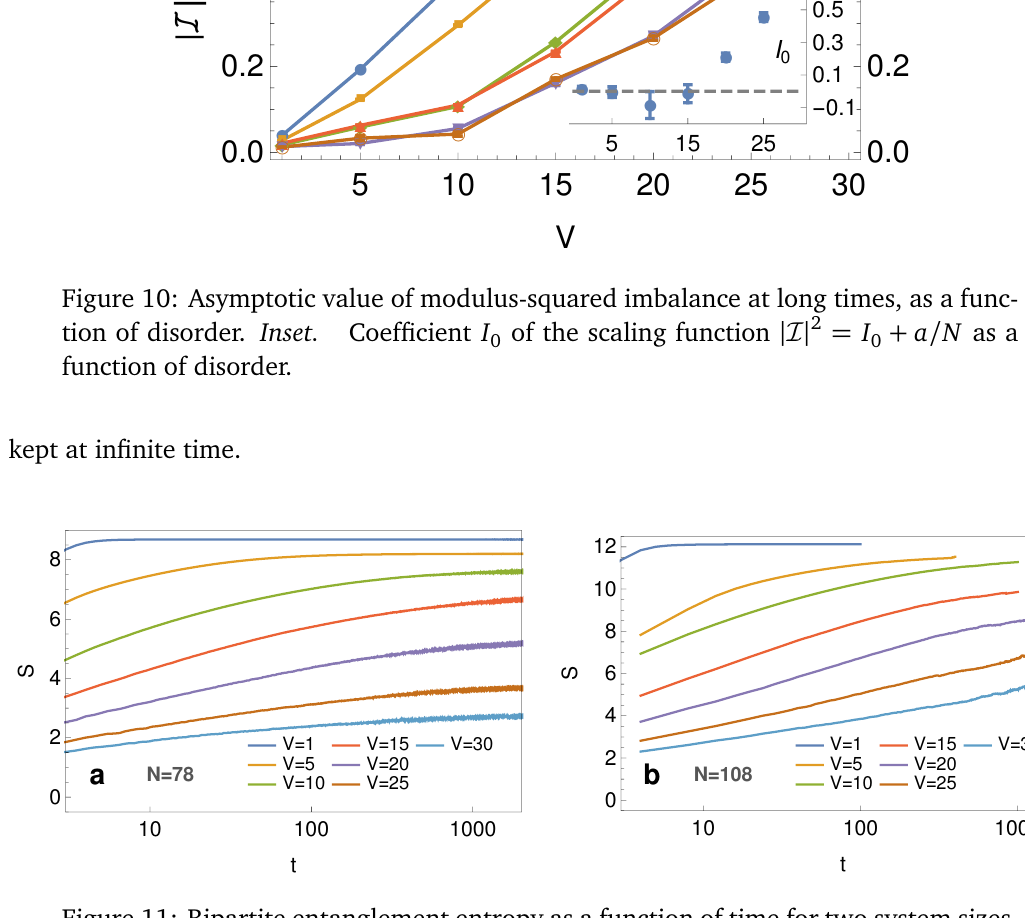
Figure 11: Bipartite entanglement entropy as a function of time for two system sizes, N = 78 (panel a ) and N = 108 (panel b ), showing a logarithmic growth at high disorder ( V ≥